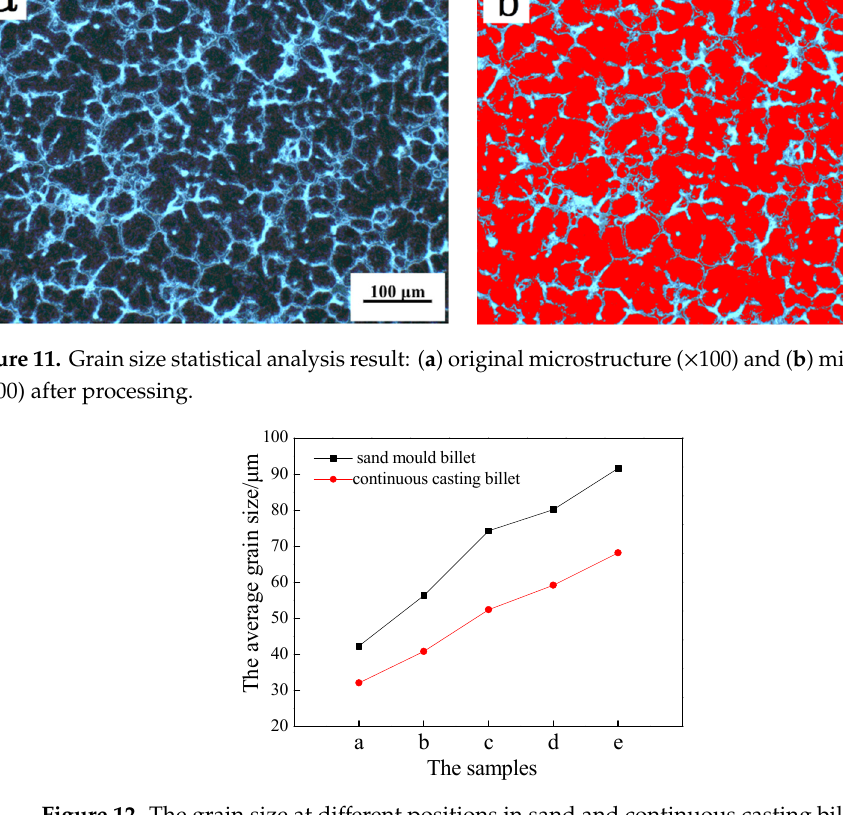
Figure 12. The grain size at different positions in sand and continuous casting billets.